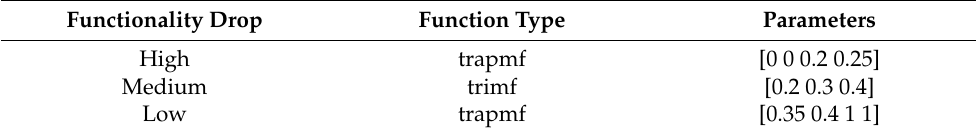
Table 2. Functionality drop membership functions with three terms.